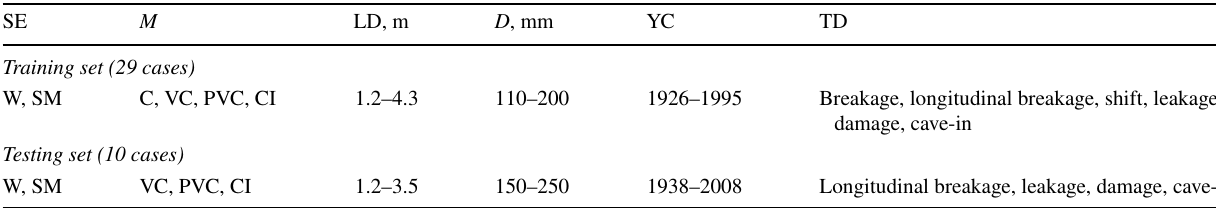
Table 2 Ranges of predictors and dependent variable—sewer